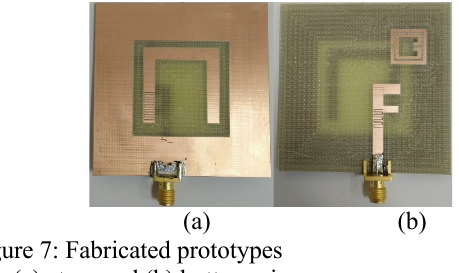
Figure 7: Fabricated prototypes (a) top, and (b) bottom views